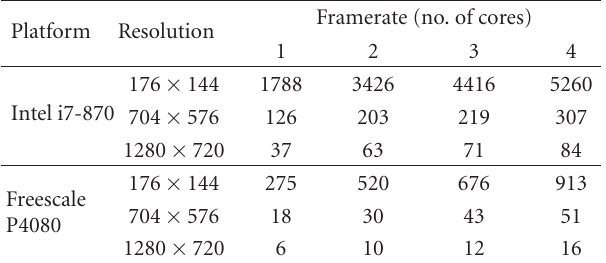
Table 2: Framerate of the YUV-parallel MPEG-4 SP decoder at QCIF, SD and HD